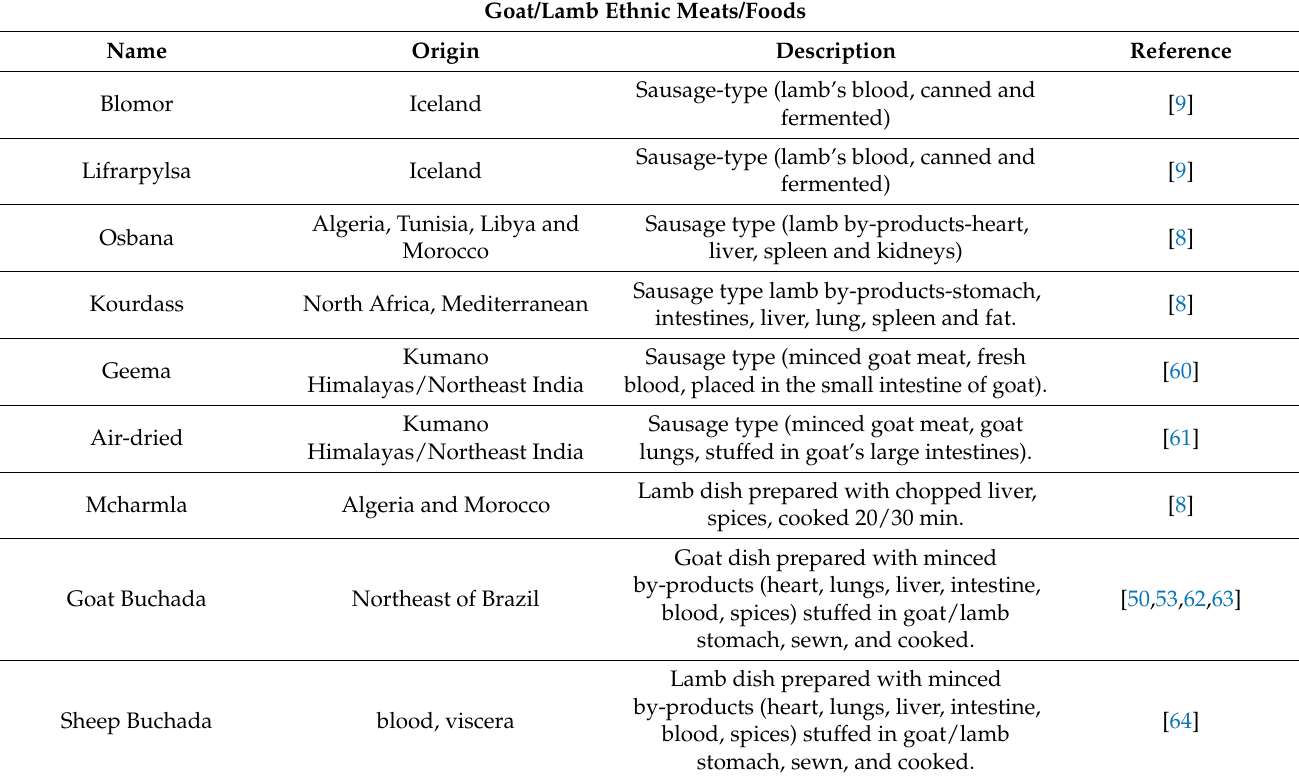
Table 3. Goat and sheep products processed from by-products. Goat/Lamb Ethnic